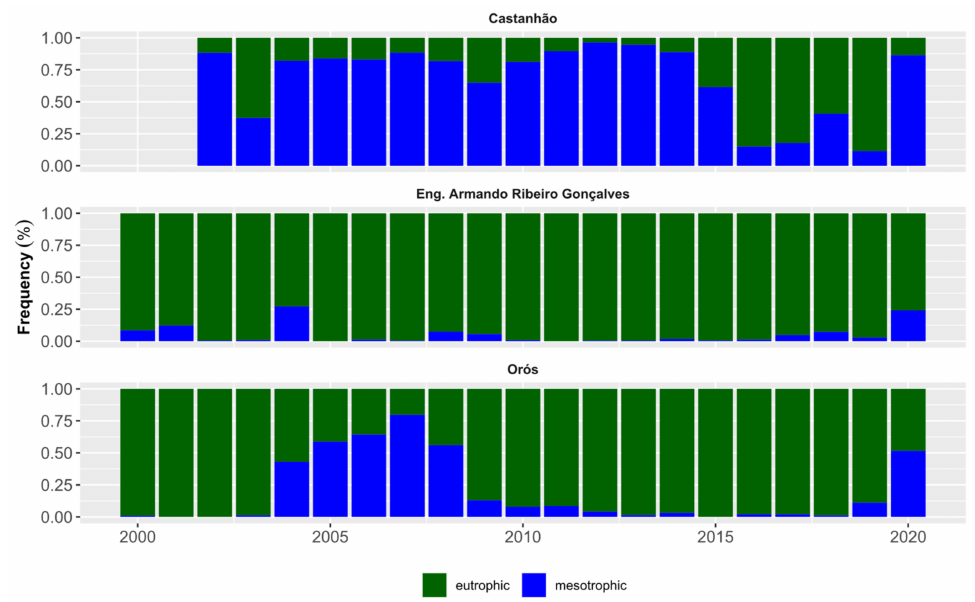
Figure 5. The annual relative frequency of eutrophic and mesotrophic states in the three largest study lakes.